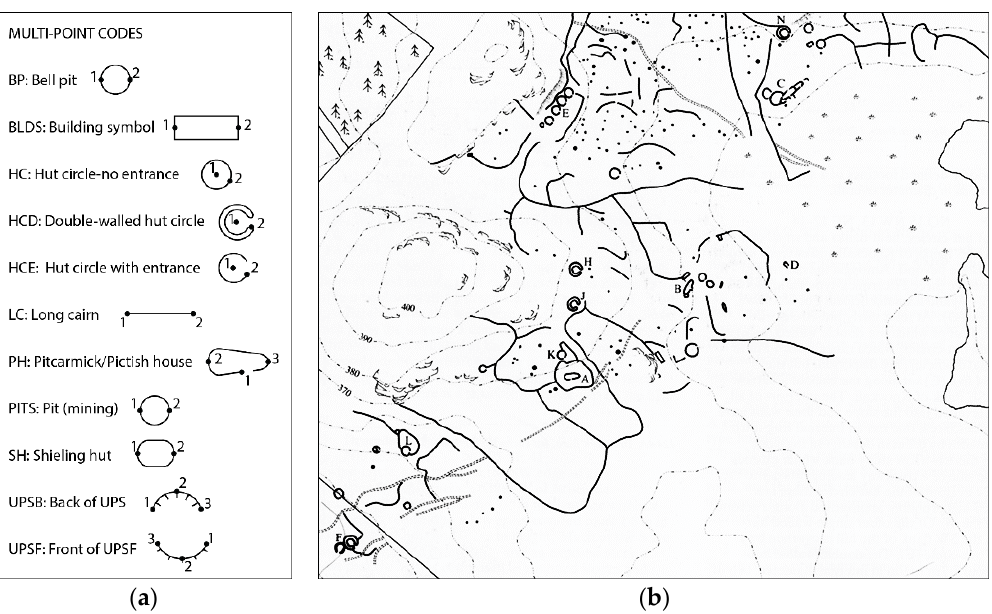
Figure 4. The use of simple codes for landscape mapping at 1:10,000 scale was designed to help expedite rapid coverage, as illustrated by an extract from a field reference sheet ( a ). However, a clear tendency can be identified towards mapping in more detail, with a shift in survey specification, sometimes underpinned by an implicit assumption that more detail is automatically ‘better’ illustrated ( b ) by an extract from mapping in north-east Perthshire [31]). © Historic Environment Scotland.